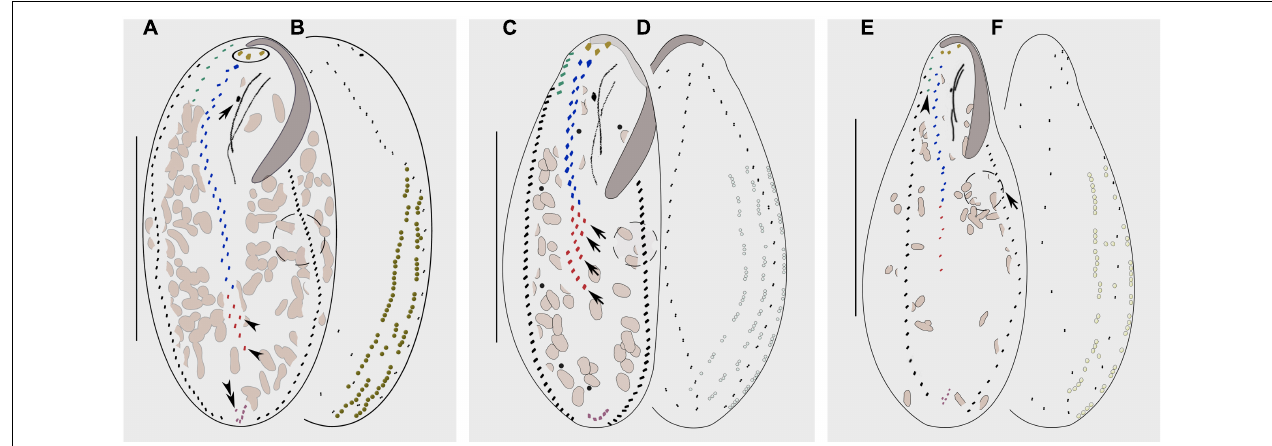
FIGURE 7 | Morphology of Bakuella subtropica (A,B) , Bakuella agamalievi (C,D) , and Bakuella incheonensis (E,F) . (A,C,E) Ventral view of three individuals. (B,D,F) Dorsal views of three individuals and cortical granules on dorsal side. (A) Ventral view to show the infraciliature; circle marks the frontal cirri, arrow shows the buccal cirrus, arrowheads indicate the ventral rows, and double arrowheads show the pretransverse cirrus. (B) Distribution of cortical granules, which form longitudinal rows. (C) Ventral view of infraciliature; arrows mark the short ventral rows. (D) Distribution of cortical granules, typically grouped together and sparsely arranged in short longitudinal rows. (E) Ventral view of infraciliature, arrow marks the contractile vacuole, and arrowhead indicates the frontoterminal cirri. (F) Distribution of cortical granules, mainly distributed along cirral rows and dorsal kineties. Scale bars: (A–D) = 60 µ m, (E,F) = 40 µ m.